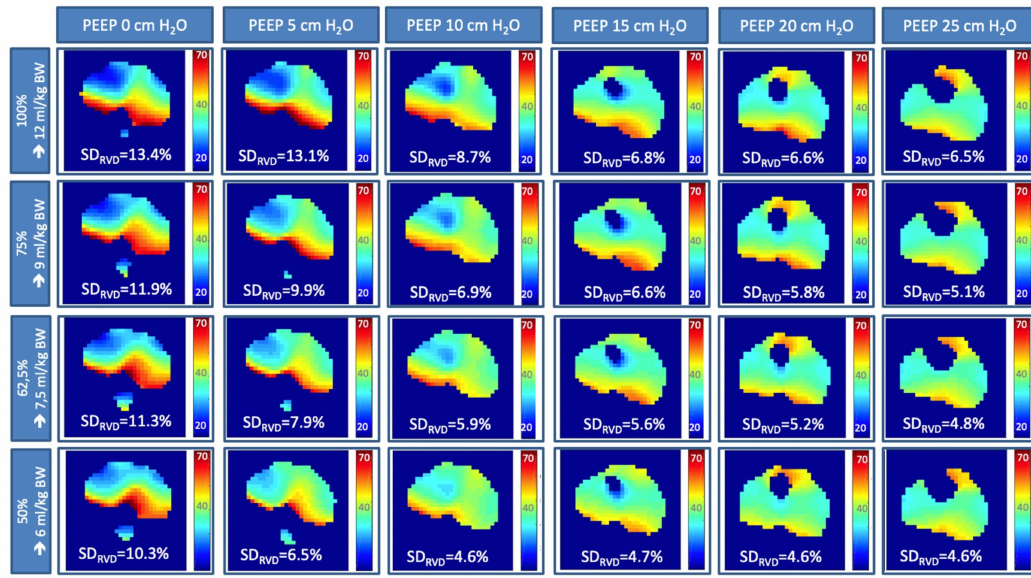
Figure 3. Regional ventilation delay (RVD) analyses, color-coded RVD maps and RVDI values (in % inflation time) obtained by electrical impedance tomography (EIT) during a slow inflation with tidal volumes of 12, 9, 7.5, and 6 mL / kg at PEEP levels of 0, 5, 10, 15, 20, and 25 cmH 2